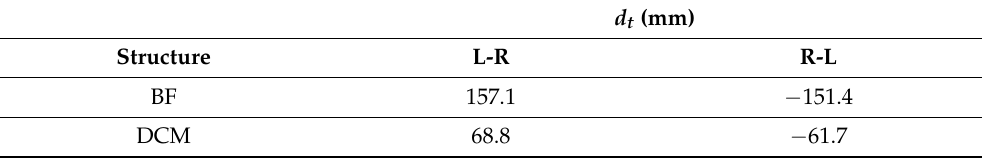
Table 4. Target displacement values d t for the LS of NC (L-R: left-to-right; R-L: right-to-left).